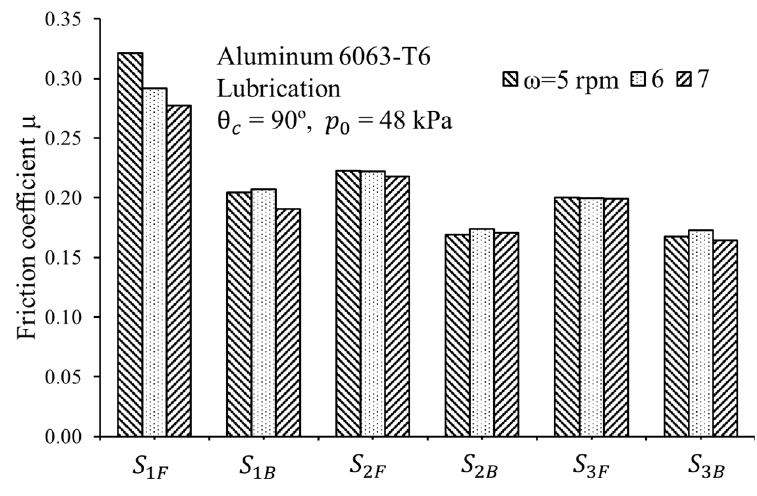
Figure 12. E ff ects of rotation speed on friction coe ffi cient under lubricated conditions for aluminum Figure 12. Effects of rotation speed on friction coefficient under lubricated conditions for aluminum alloy 6063-T6 strips. alloy 6063-T6 strips.